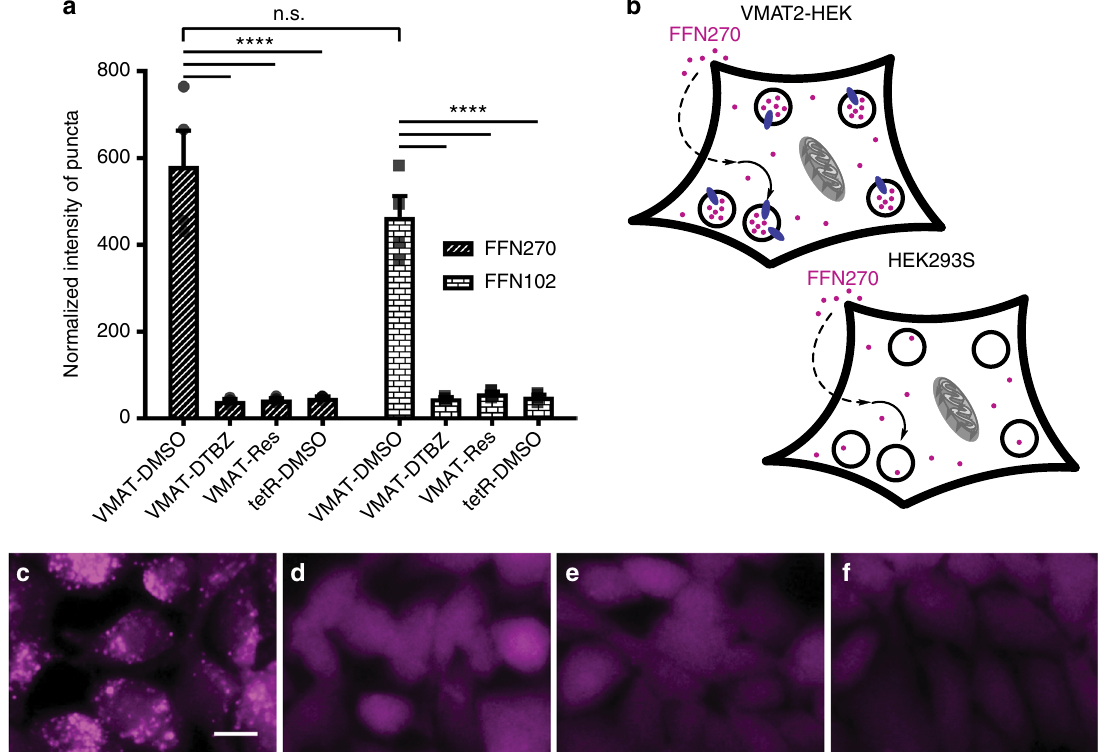
Fig. 2 FFN270 is a VMAT2 substrate. a VMAT2-dependent loading of FFN102 and FFN270 were compared using the normalized intensity of puncta (number of puncta multiplied by average fl uorescence intensity ± SEM, n = 4 independent experiments) in VMAT2-HEK cells after a 2 h incubation (20 µ M) under different conditions. FFN270 showed robust puncta intensity (581 ± 81), comparable to FFN102 (464 ± 49), that was signi fi cantly diminished in dTBZ (41 ± 4) and reserpine (44 ± 3) inhibited conditions ( P < 0.0001, one-way ANOVA Dunnett test). b Representative schematic depicting the rationale for intracellular punctate fl uorescence with active VMAT2, and general cytosolic labeling in null-transfected or inhibited conditions. The probes passively diffuse through the plasma membrane and are then actively concentrated in acidic compartments that express VMAT2. Representative images of FFN270 in c VMAT2-HEK cells, d dTBZ (2 µ M) or e reserpine (2 µ M) inhibited VMAT2-HEK cells, and f null-transfected HEK293 cells. Scale bar: 10 µ